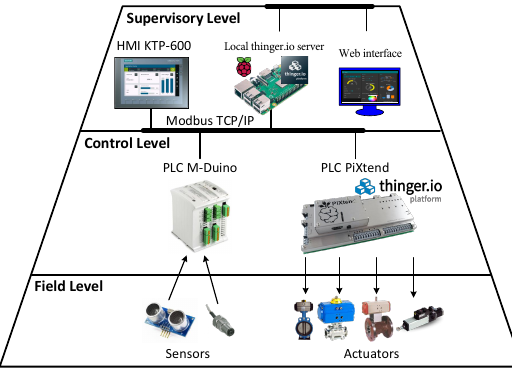
Figure 2. Automation system architecture.